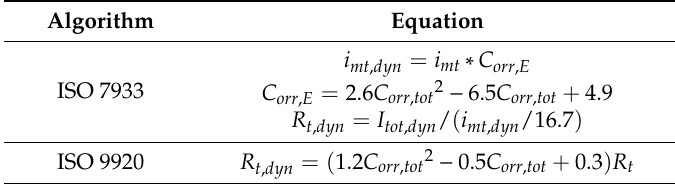
Table 4. Calculation of the dynamic evaporative resistance according to ISO 7933 and ISO 9920.